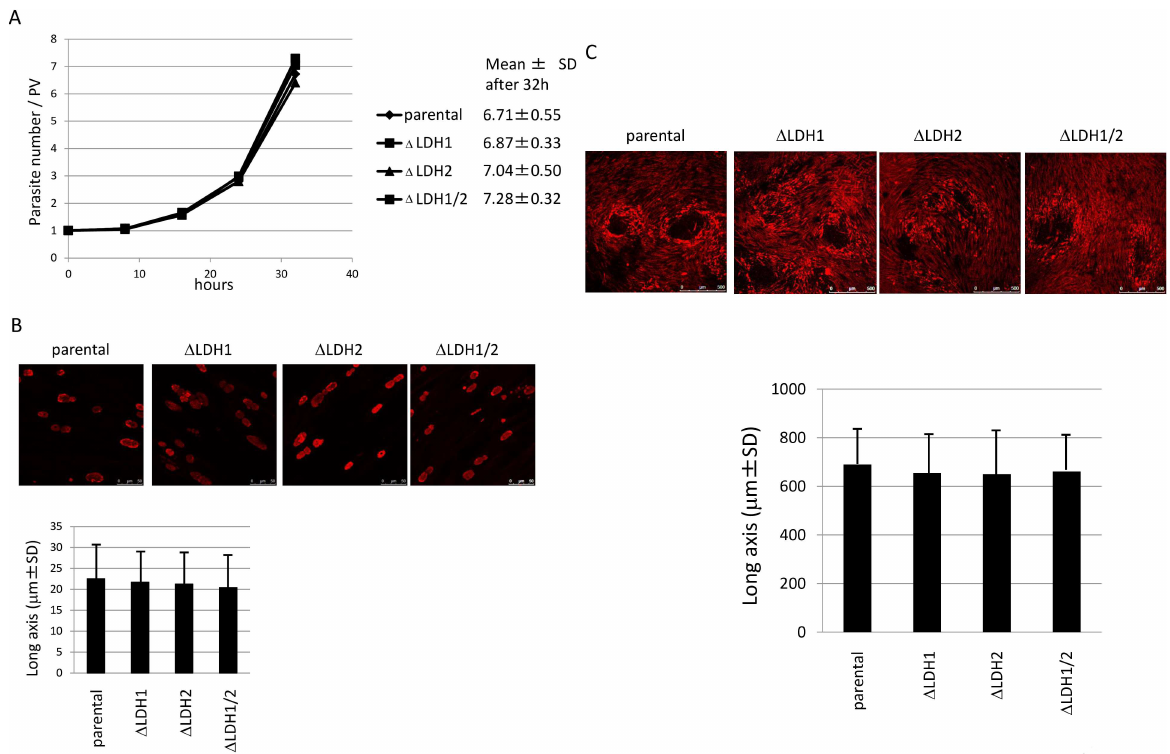
Fig 2. Growth kinetics. (A) The graph shows the averagenumberof parasitesper PV at the indicatedtime points. The numbers on the right side represent the averagenumber of parasites per vacuole32 hours after incubation. (B) Comparison of PV size with parental and knockout strains. PVs are visualizedby immunostaining with anti-IMC antibodies(upper panel). Size of PVs was measuredand represented as a graph (lower panel). (C) Parasite plaqueswere stained with anti-IMC1 antibody. The photos show the parental and knockout strains (upper panel). Plaquesize was measuredand representedas a graph (lower